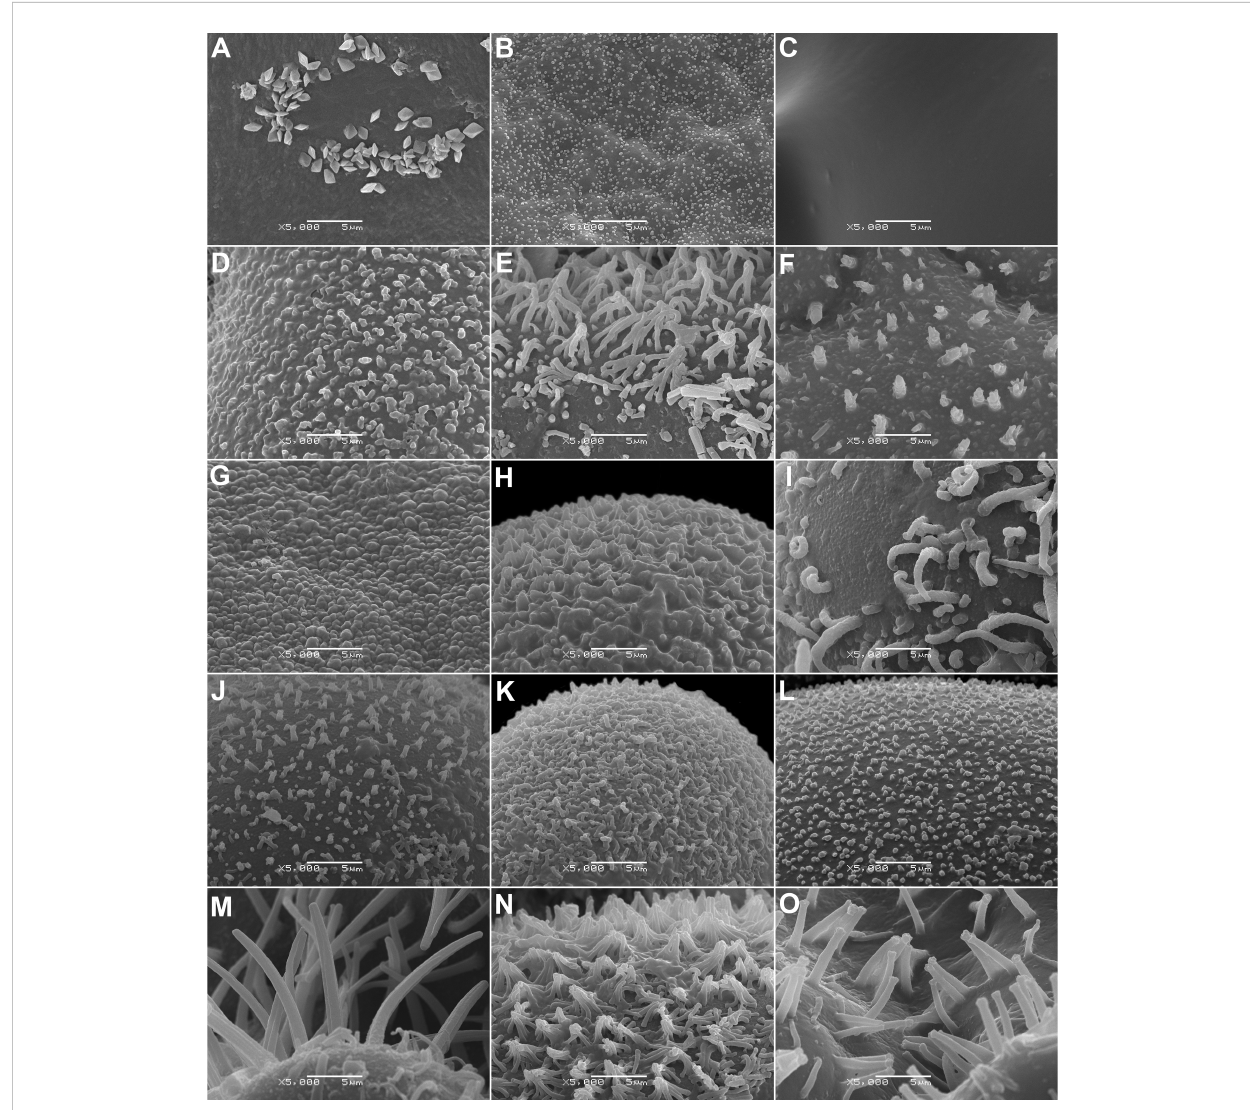
FIGURE 7 SEM micrographs of a seed surface of selected Aizoaceae species at 5000× magni fi cation showing wax crystals of different shapes or glabrous surface. (A) Gunniopsis papillata (prismatic crystals), (B) Gunniopsis calva ( fl ake-like crystals), (C) Aizoon paniculatum (no wax deposits), (D) Aptenia cordifolia ( fl ake-like crystals), (E) Mesembryanthemum aitonis ( fi nger-like crystals), (F) Mesembryanthemum lignescens ( fl ake-like crystals), (G) Conicosia elongata ( fl ake-like crystals), (H) Acrodon parvifolius ( fl ake-like crystals), (I) Astridia longifolia ( fi nger-like crystals), (J) Disphyma crassifolium ( fl ake-like crystals), (K) Eberlanzia gravida ( fl ake-like crystals), (L) Esterhuysenia drepanophylla ( fl ake-like crystals), (M) Glottiphyllum linguiforme ( fi nger-like crystals), (N) Khadia acutipetala ( fl ake-like crystals), and (O) Namaquanthus vanheerdei ( fi nger-like